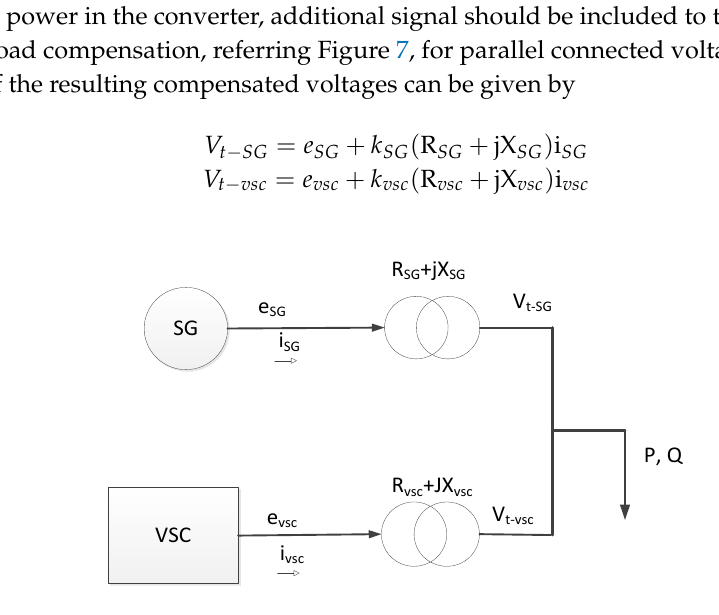
Figure 7. Voltage droop control for parallel connected voltage-control units.